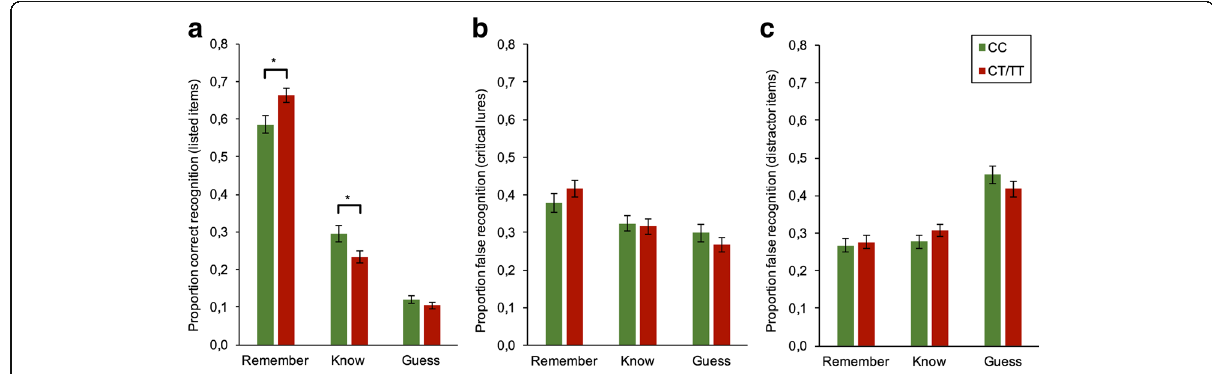
Fig. 2 Proportion of Remember / Know / Guess Judgments out of all ‘ old ’ responses to listed items, critical lures, and distractors in the recognition test. a ) Remember/know/guess responses during correct recognition trials (listed items). b ) Remember/know/guess responses during false recognition trials (critical lures). c ) Remember/know/guess responses during false alarm trials (distractors). Data expressed as means ± SEM. * P